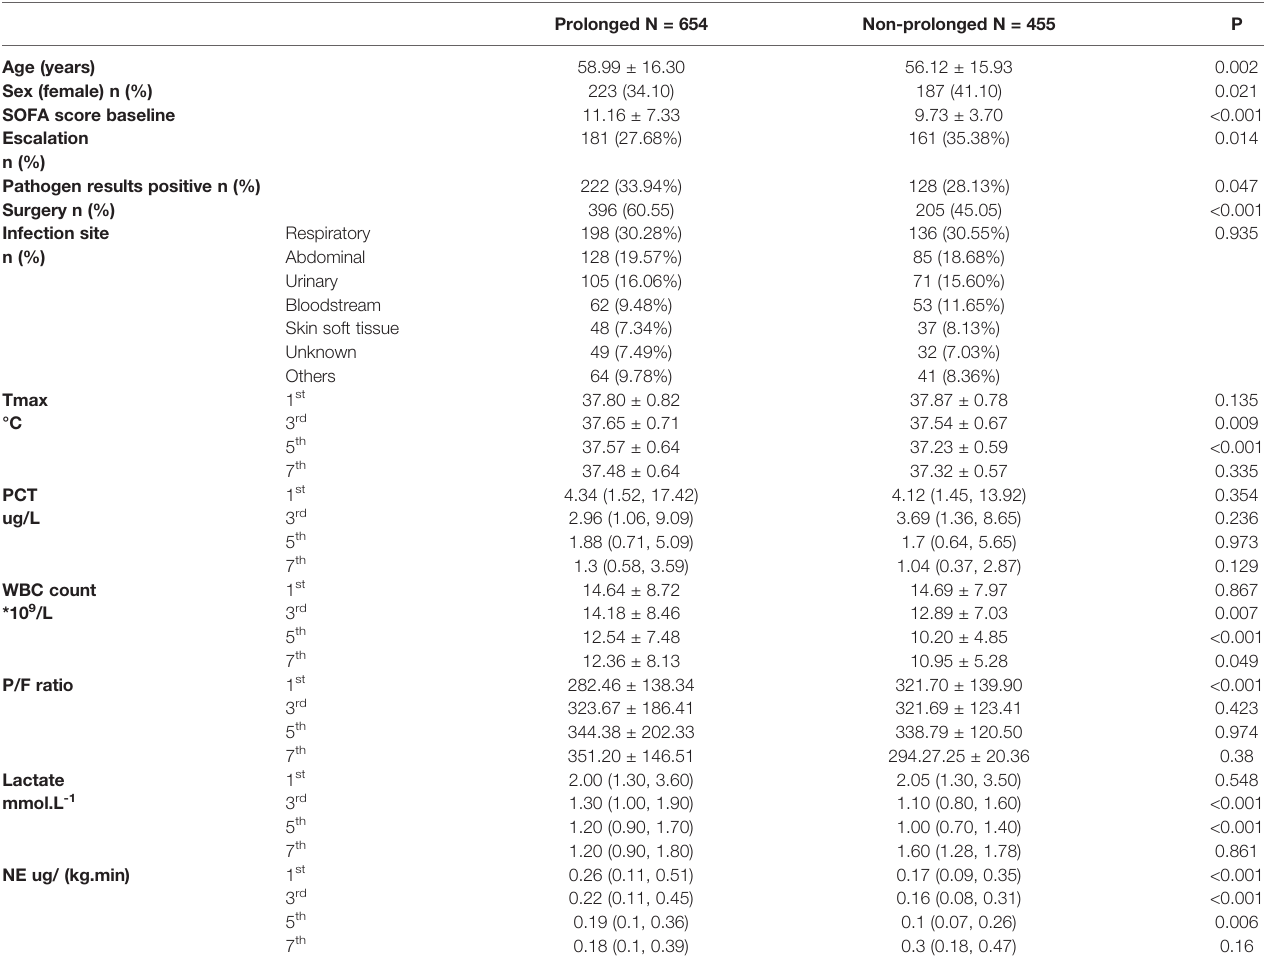
TABLE 1 | Baseline characteristics of the two